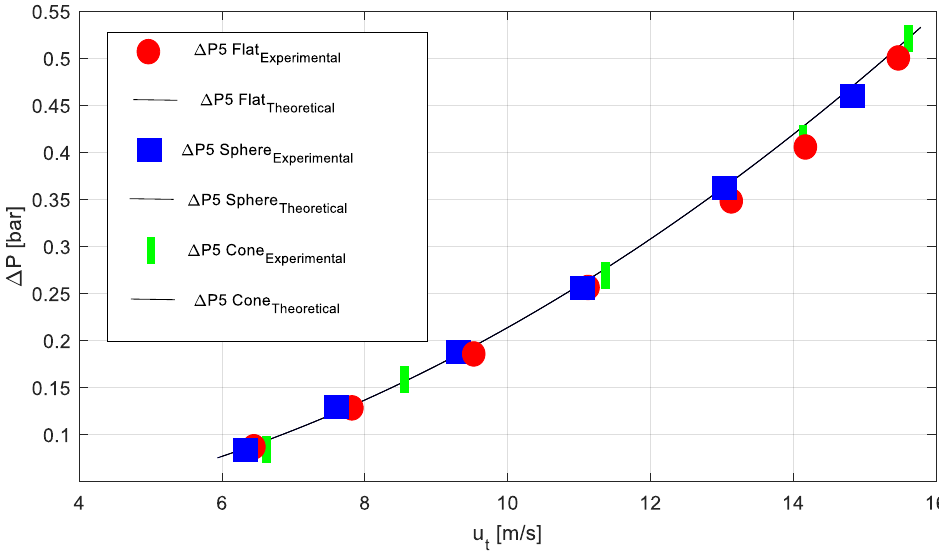
Δ P P P = − vs. the 5 t